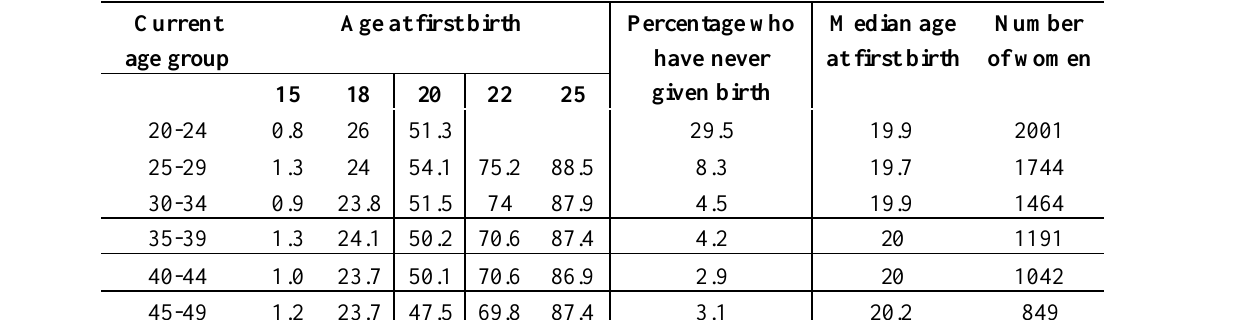
Source: Nepal Demographic and Health Survey 2001 table